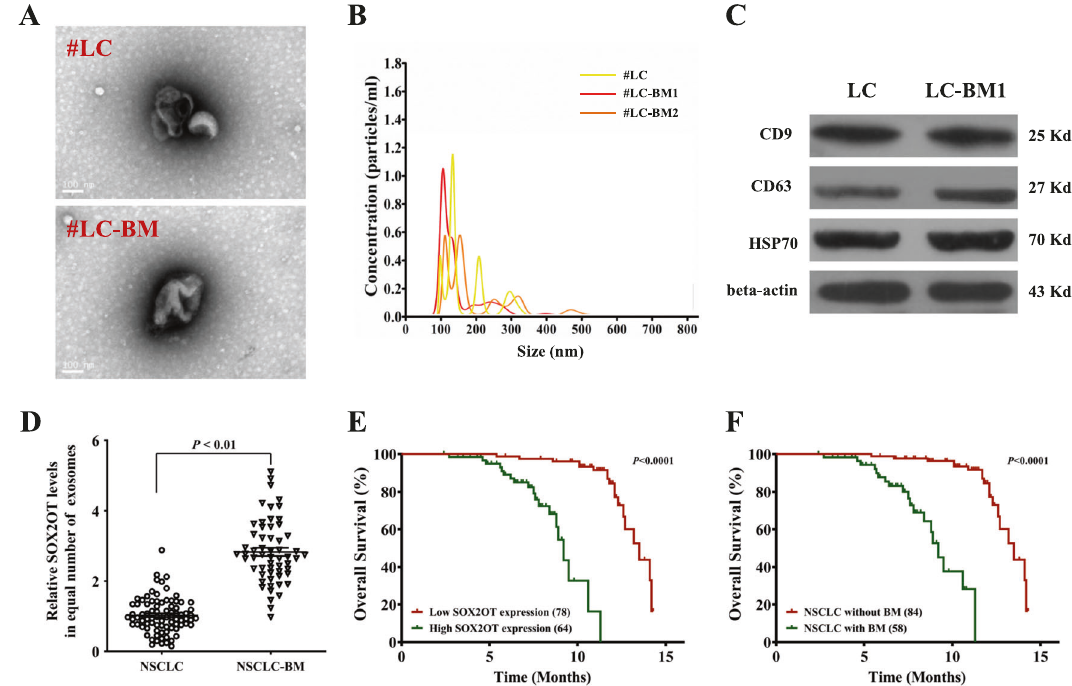
Fig. 1 LncRNA-SOX2OT-enriched exosomes in the plasma of NSCLC patients correlate with BoM. A Exosomes derived from the plasma of NSCLC patients with or without BoM were phenotyped (purity and shape) by transmission electron microscopy. Scale bar, 100 nm. B The size and particle count of the indicated exosomes with an LM10 nanoparticle characterisation system. Data are representative of three biological replicates. The representative pictures are presented. C Western blotting was performed to detect the expression of exosomal markers, CD9, CD63 and HSP70. Beta-actin was used as a reference protein. Data are representative of three biological replicates. D A real-time PCR assay was performed to determine the lncRNA-SOX2OT level in exosomes derived from the plasma of lung cancer patients with or without BoM. GAPDH was used as the internal control. E The Kaplan-Meier analysis was executed to determine the correlations between BoM and OS. F The Kaplan – Meier analysis was also performed to determine the correlations between the level of lncRNA-SOX2OT in exosomes and OS. *, P < 0.05; **, P < 0.01 ( t test). Data are representative of three biological